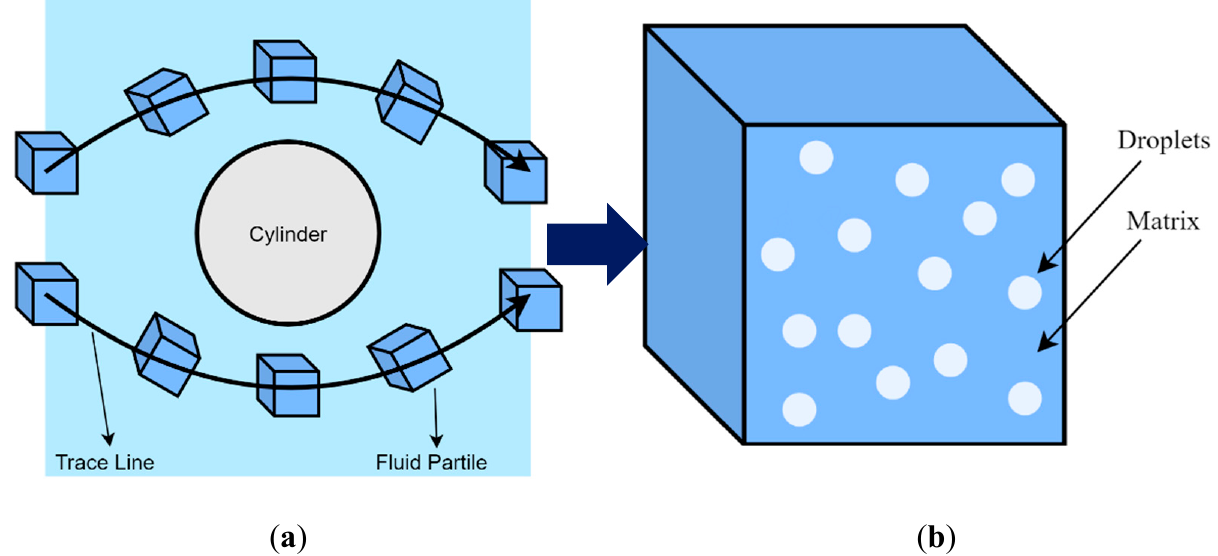
Figure 7. Particle-based scale-bridging method: ( a ) a fluid particle trace in the flow around circular cylinder; ( b ) a fluid particle containing droplets.